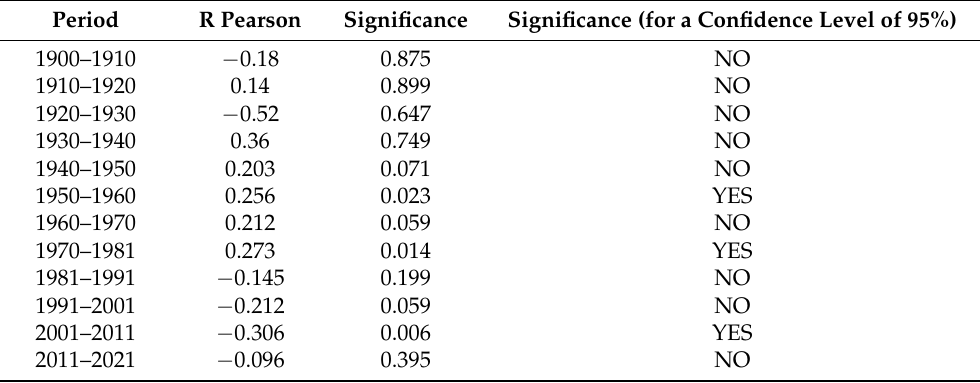
Table 1. Pearson test (initial population size-population growth variables). Period R